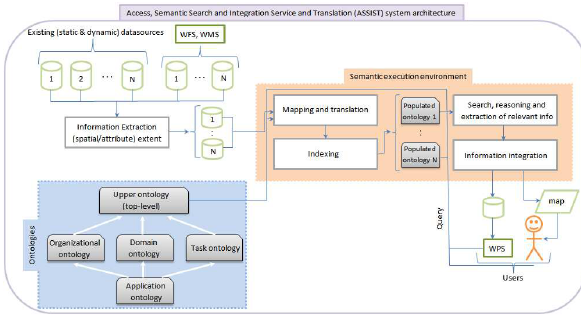
Figure 2. System web architecture for semantic annotation of existing geo-datasets (Mobasheri,